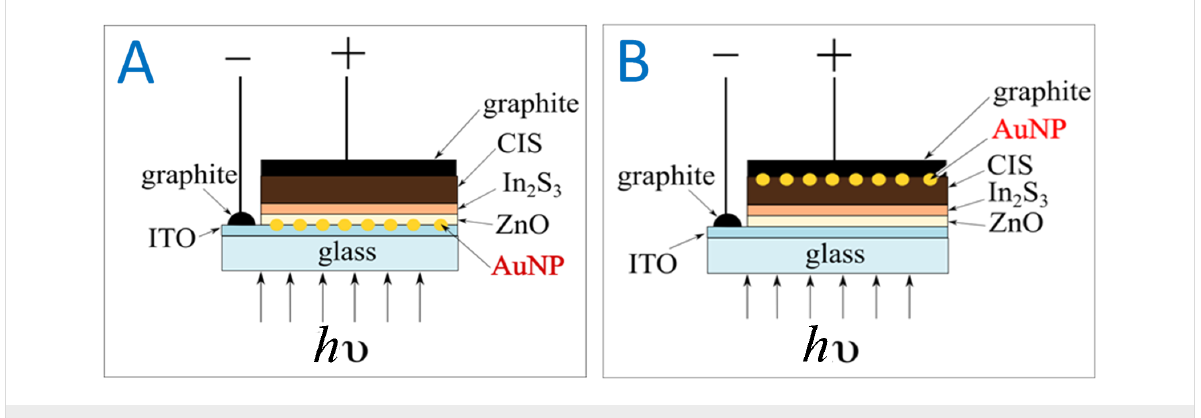
Figure 1: Sketch of the cross-section of the Au-NP/ZnO/In 2 S 3 /CuInS 2 solar cell (A), and of the ZnO/In 2 S 3 /CuInS 2 /Au-NP solar cell (B), all layers prepared by chemical spray using ITO/glass substrates.